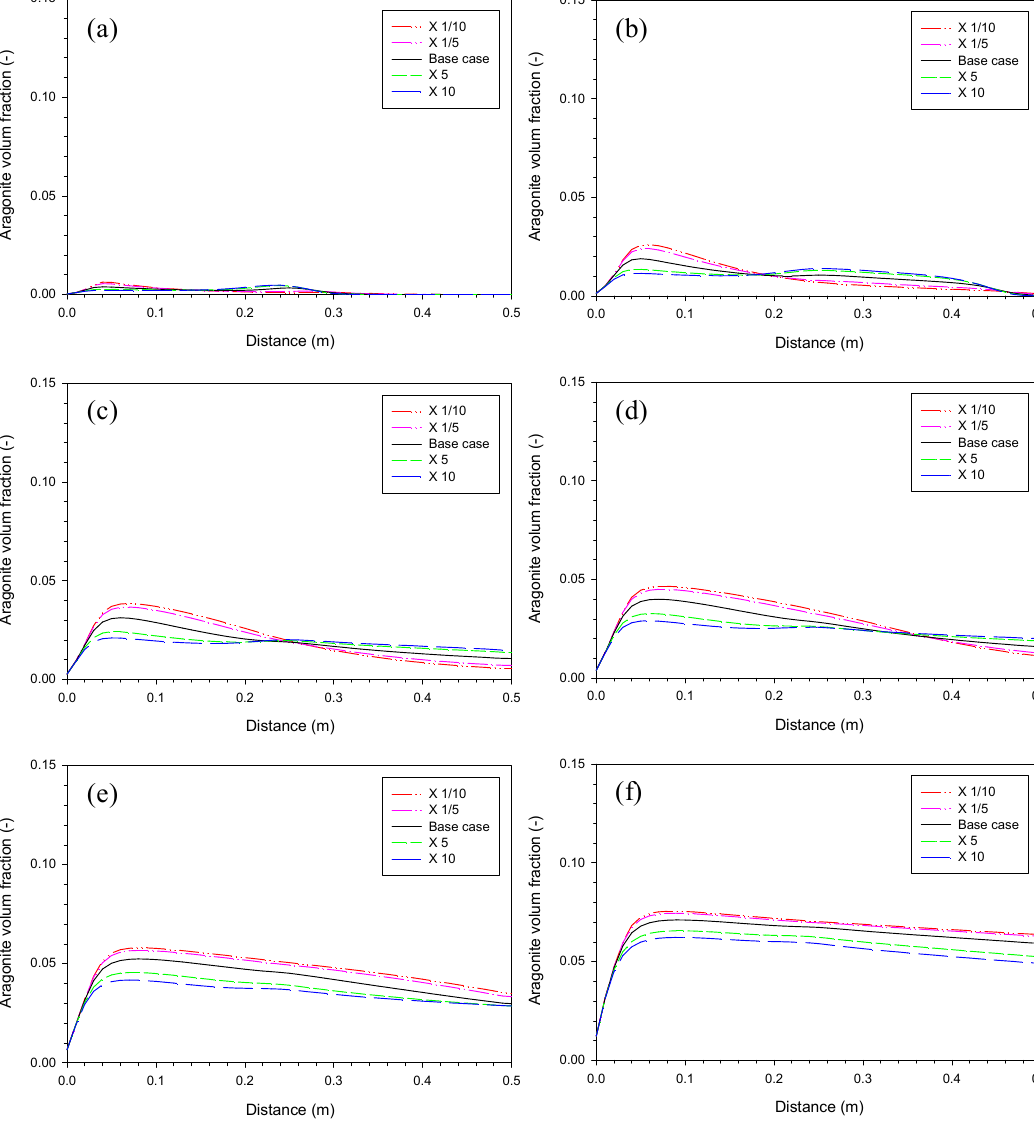
Figure 6. Sensitivity analysis of Fe 2 (OH) 2 CO 3 (s) precipitation rate. Aragonite volume fraction on ( a ) Day 4, ( b ) Day 25, ( c ) Day 54, ( d ) Day 87, ( e ) Day 164, and ( f ) Day 410 with value of the base case, × 1/10, × 1/5, × 5, and × 10.